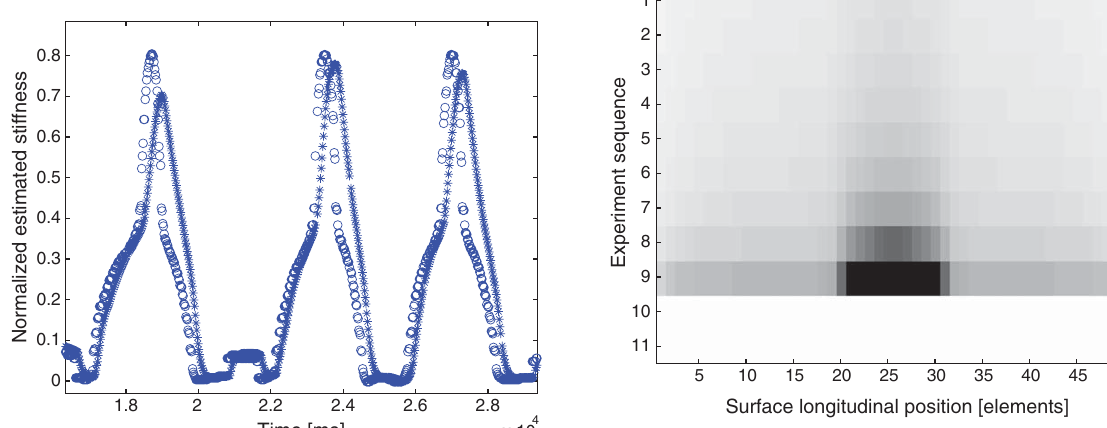
Fig. 16. The perceived stiffness was measured allowing the subject to interact on different surfaces. The figure represents the stiffness along the surface in the nine experiments conducted. The perceived stiffness was normalized over the biggest recorded